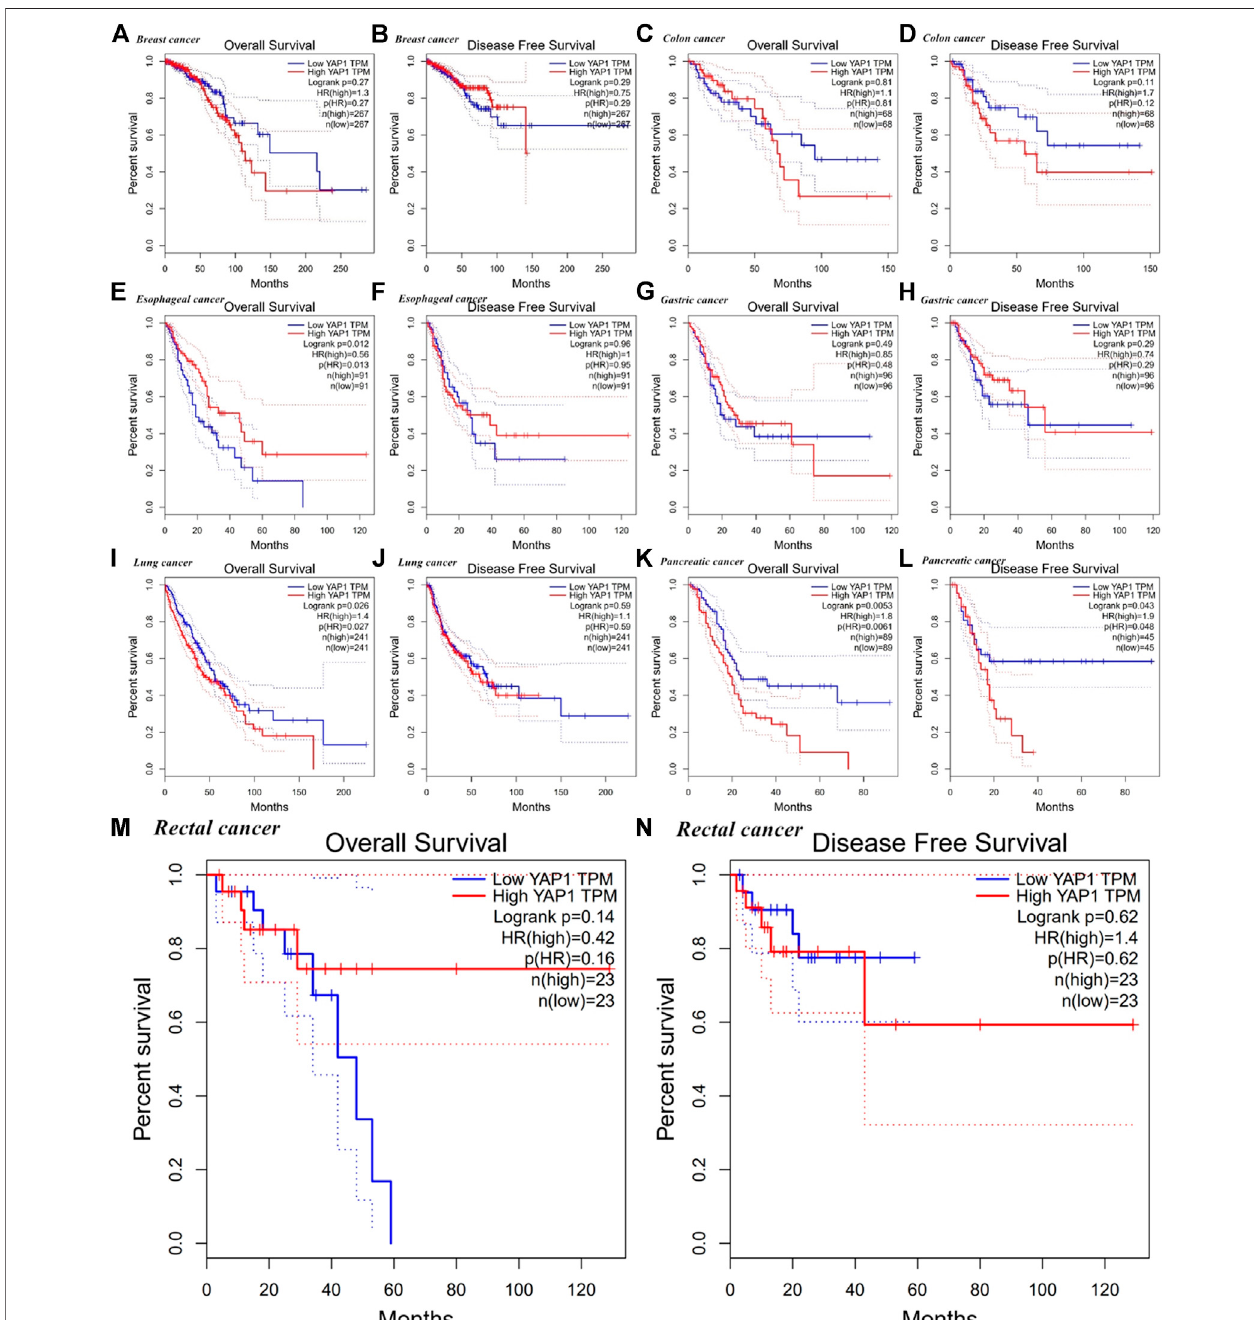
FIGURE 5 | Kaplan – Meier survival curves for high and low YAP1 expression in different types of cancer based on GEPIA. OS, overall survival; DFS, disease-free survival; RFS, relapse-free survival; DSS, disease-speci fi c survival. DMFS, distant metastasis-free survival.